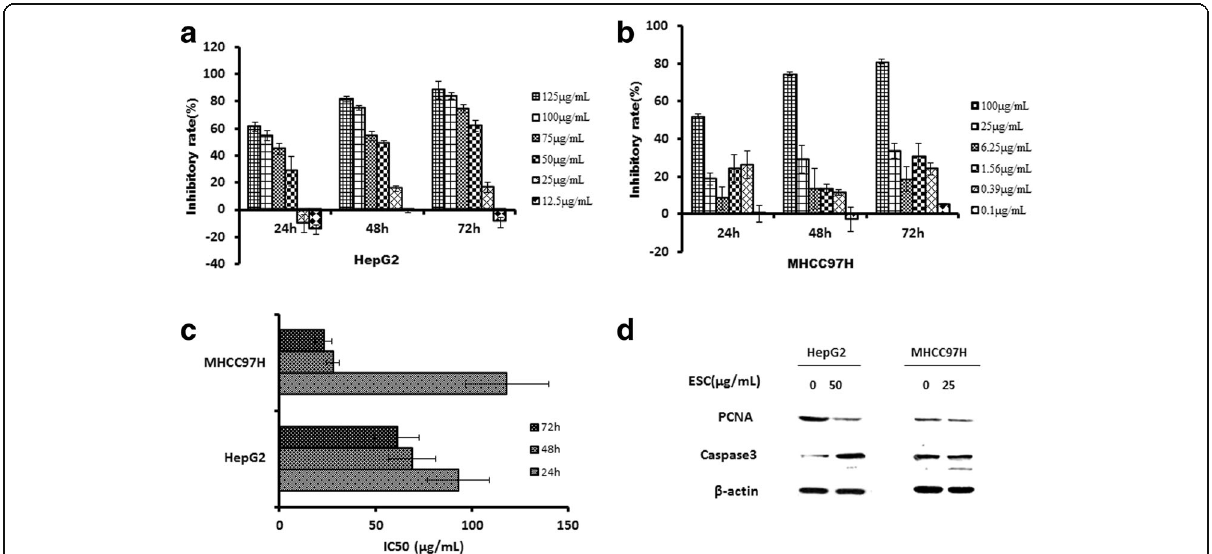
Fig. 1 Growth inhibition of ESC in HepG2 cells and MHCC97H cells. a Inhibition rates of ESC in HepG2 cells at 24, 48,72 h. b Inhibition rates of ESC in MHCC97H cells at 24, 48,72 h. c IC50 values of ESC in HepG2 and MHCC97H cells at 24, 48,72 h. d Influence of ESC on PCNA and caspases 3 expression in HepG2 cells and MHCC97H cells with western blot